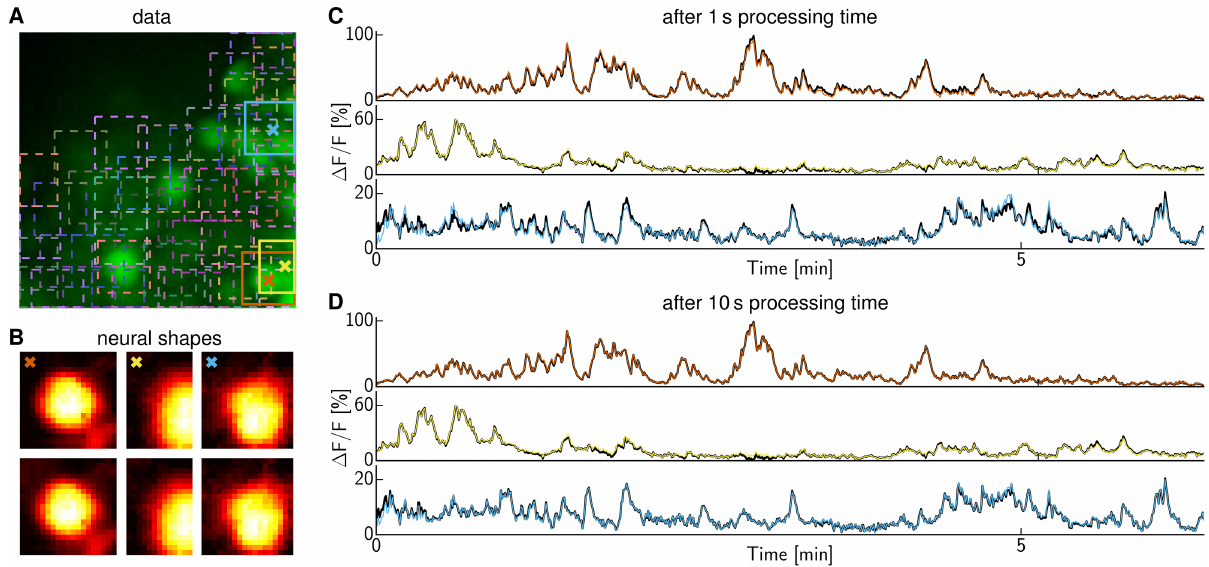
Fig 2. CNMF with and without initial decimation to speed up CNMF. (A) Real data summary image obtained as max-projection along time-axis. Squares indicatepatches centered at suspected neurons. The three highlightedneuronsare considered in the next panels. (B) Extracted shapes of the three neuronshighlightedin (A) using the same color code. The upper row shows the result with initial temporal decimationby a factor of 30 and spatial decimationby 3 × 3, followedby five final iterationson the wholedata. The algorithmran for merely 1 s. The lower row shows the result without any decimationand runninguntil convergence, yieldingvirtually identicalresults. (C) Extracted time traces without (thick black) and with initial iterations on decimateddata (color as in A) overlap well after merely 1 s. (D) They overlap almost perfectly if the algorithmusing decimationis run not only for 1 but 10